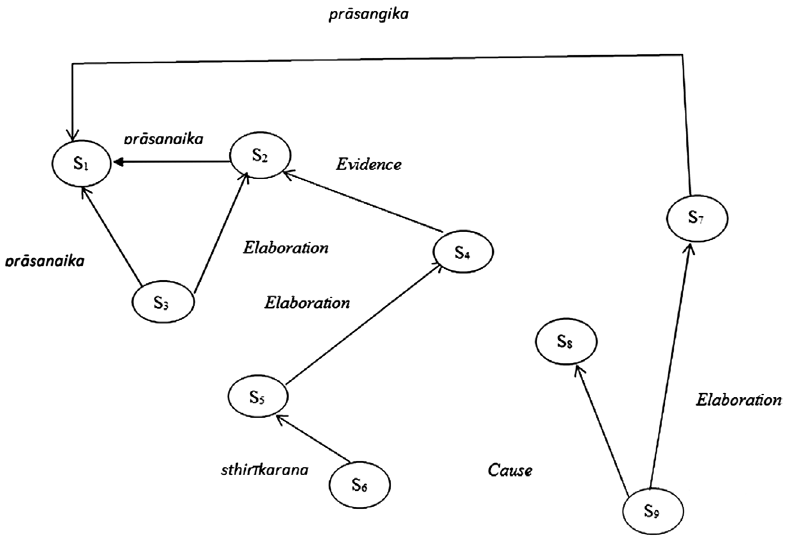
Figure 6. Discourse Structure for Example 4.